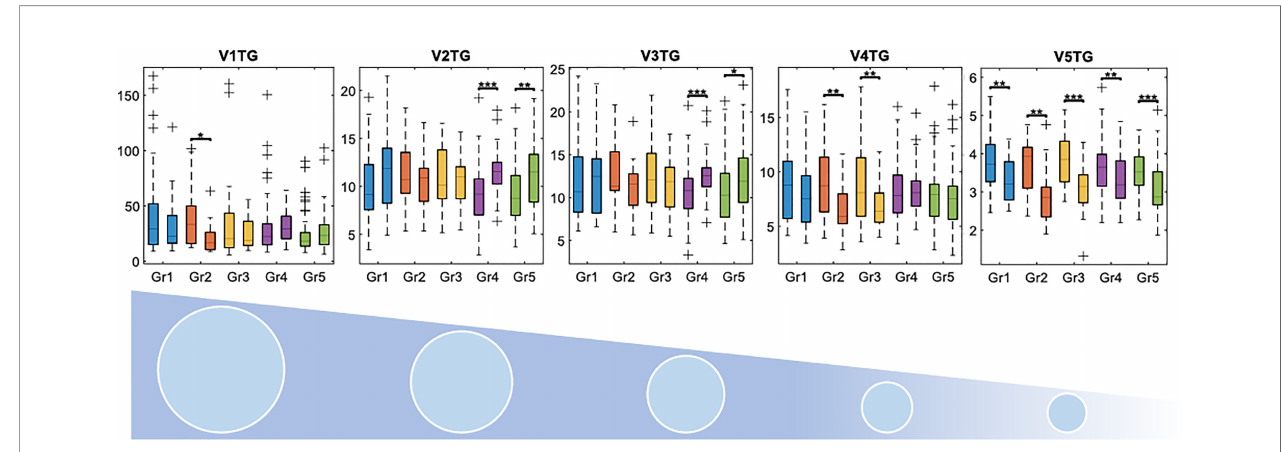
FIGURE 3 | Changes in triglyceride concentrations in the different VLDL subfractions between pre-radiation and one-year follow-up samples. V1 to V5 corresponds to subfractions VLDL1 to VLDL5, where VLDL5 has the highest density. Concentrations are displayed in mg/dL. Gr, group; TG, triglycerides. *adjusted p < 0.05, **adjusted p < 0.01, ***adjusted p < 0.001.